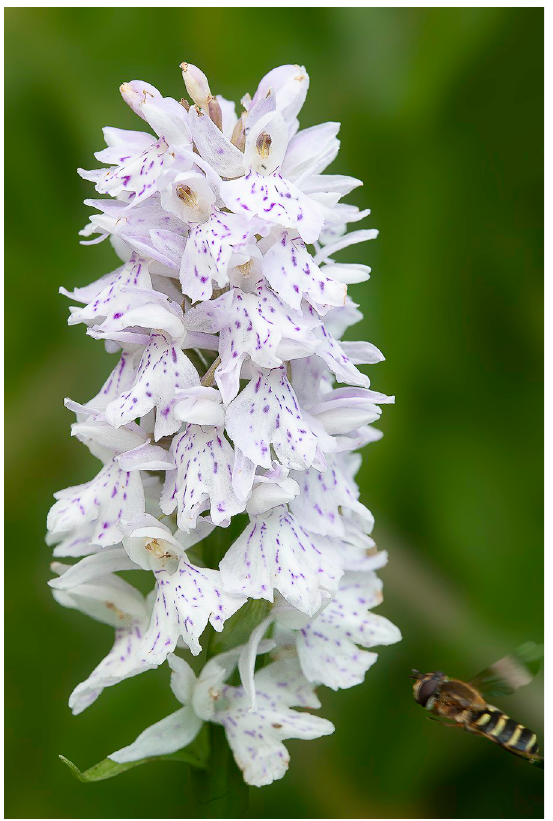
Fig 4. Dactylorhiza fuchsii (Druce) Soo´ subsp. sooana (Borsos) Borsos entire plant in its natural habitat (Fig 2), details of the inflorescences (Figs 3 and 4). One of the inflorescences (Fig 4) is visited by hoverfly of the family Syrphidae Latreille, 1802. The hoverflies, which are true bee-mimics, are very frequent visitors of D . fuschii